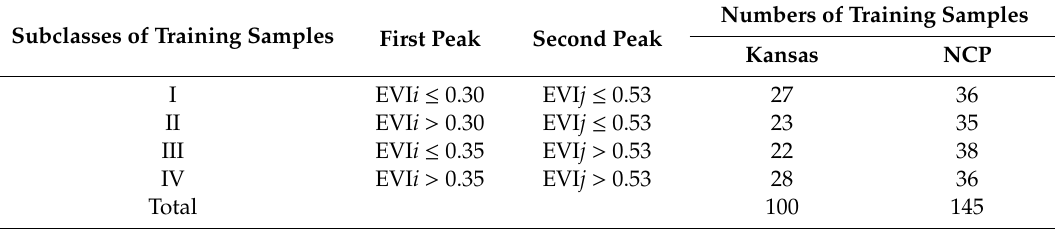
Table 3. Segmentation points and training samples of four subclasses in the two study areas 1 . Subclasses of Training Samples First Peak